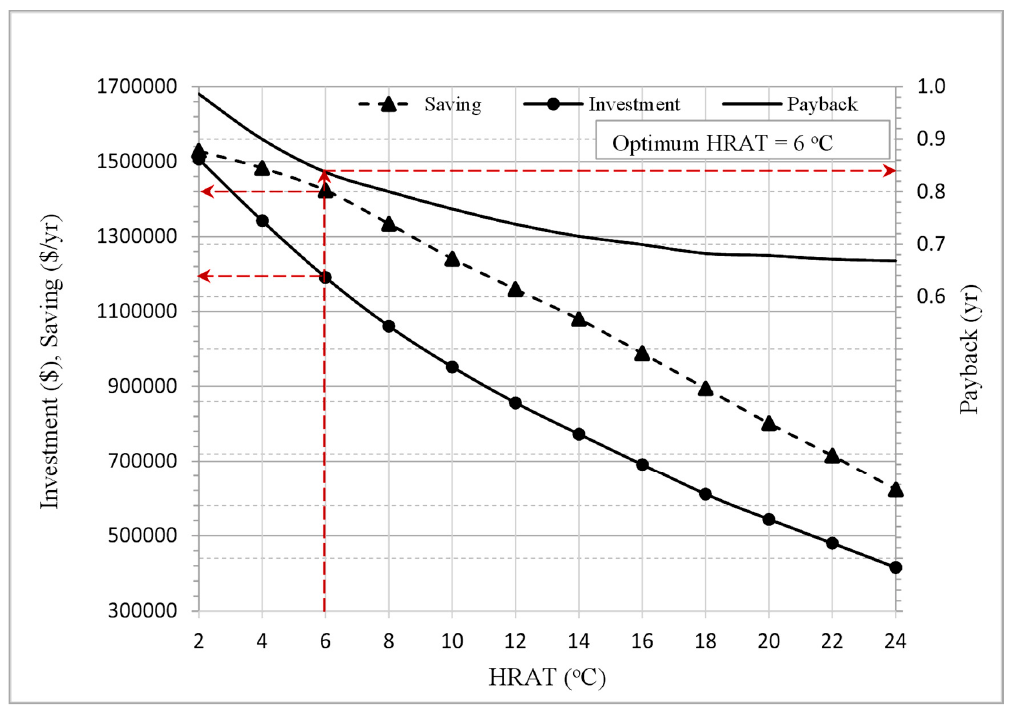
Figure 7. Investment, saving, and payback for option 2.